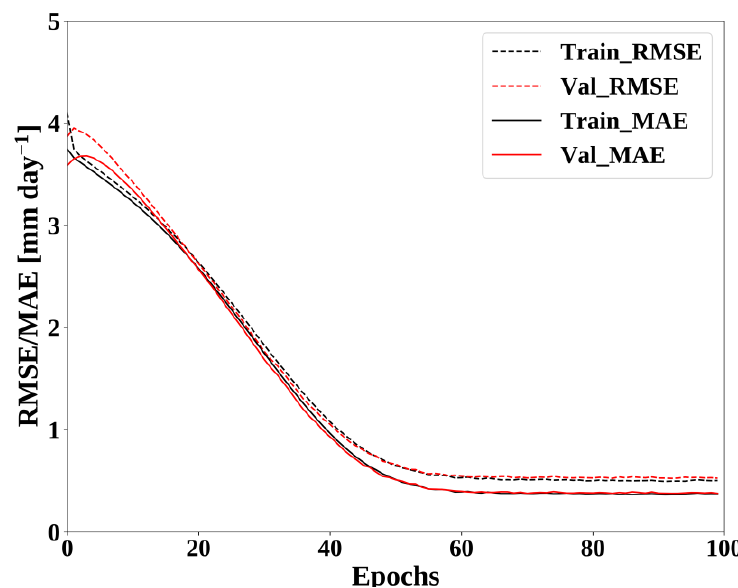
Figure 5. Changes in RMSE and MAE with respect to the training epochs of the ANN model training epochs, where Red and black lines indicate validation and training data sets, respectively; Dotted and solid lines represent RMSE and MAE, respectively.